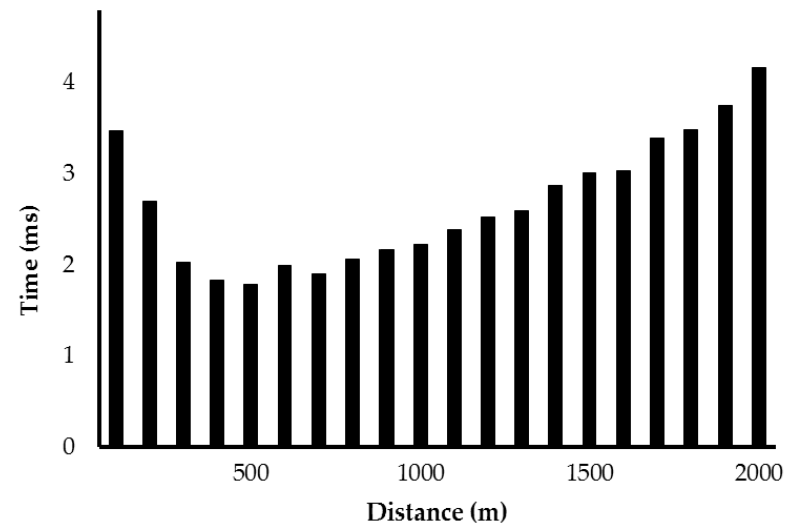
Figure 5. Performance in geospatial computation.